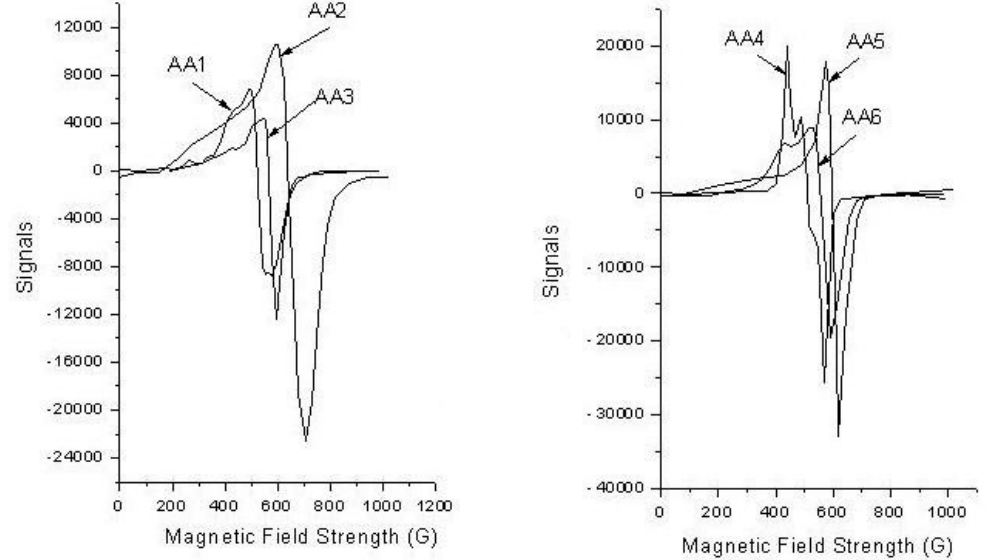
Figure 1. Electron spin resonance (ESR) spectra of NH 4 [(VO)(FA)(AA n )] complexes (where AA 1 = isoleucine, AA 2 = threonine, AA 3 = proline, AA 4 = phenylalanine, AA 5 = lysine, and AA 6 = glutamine) in